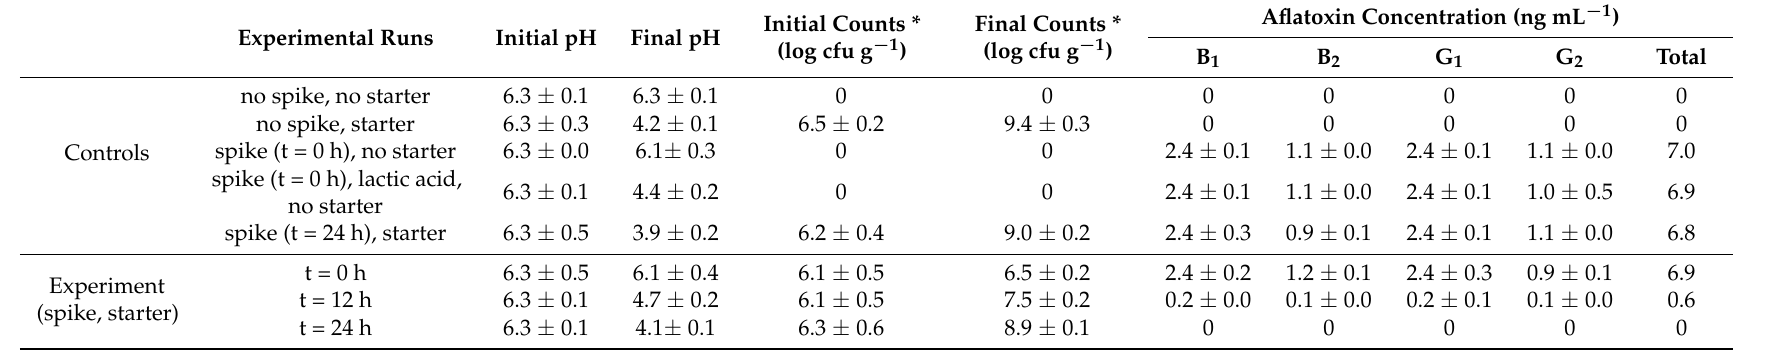
Table 3. Reduction of spiked aflatoxins B 1 , B 2 , G 1 , and G 2 after 24 h of incubation of kwete base. Values are means and standard deviations of analyses from